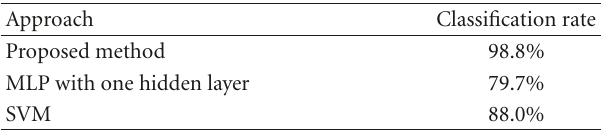
Table 3: Classification performances of di ff erent classifiers using the spectrogram as